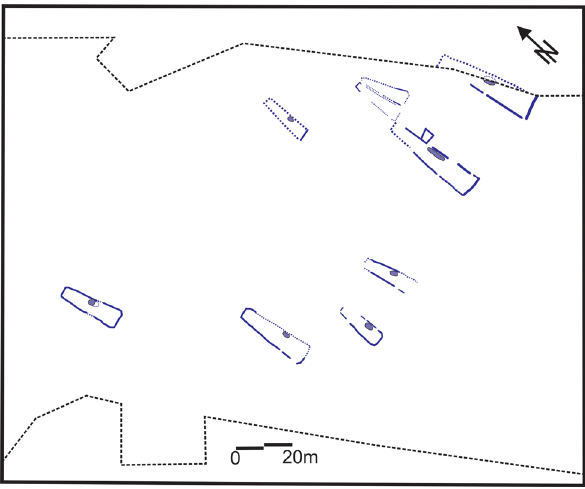
Figure 2: Houses of the Brze ść Kujawski Group with distinct cellar pits at Bodzia 1 ( abridged from Kabaci ń ski et al., 2014, Figure 2 )